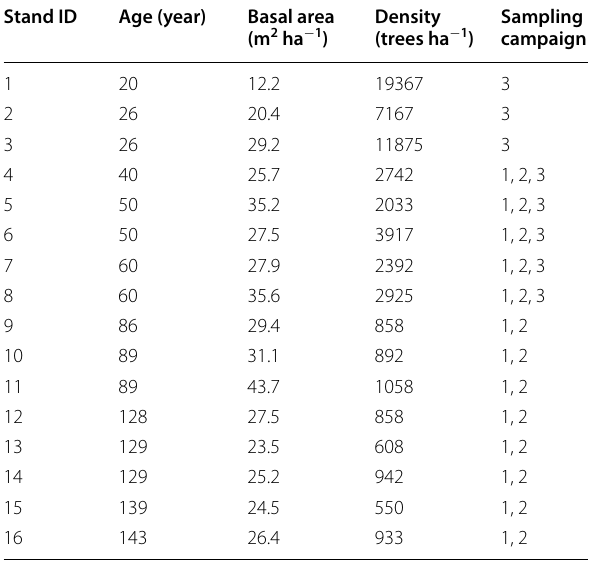
Table 1 Characteristics of the 16 selected stands in an oak- dominated naturally regenerated